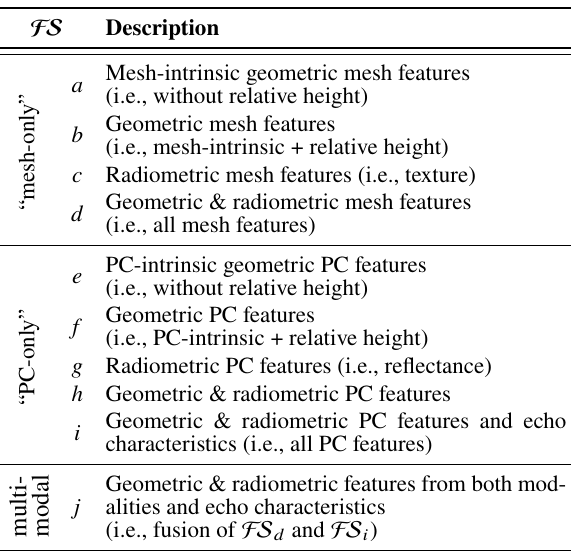
Table 1. Overview of the feature vector compositions FS